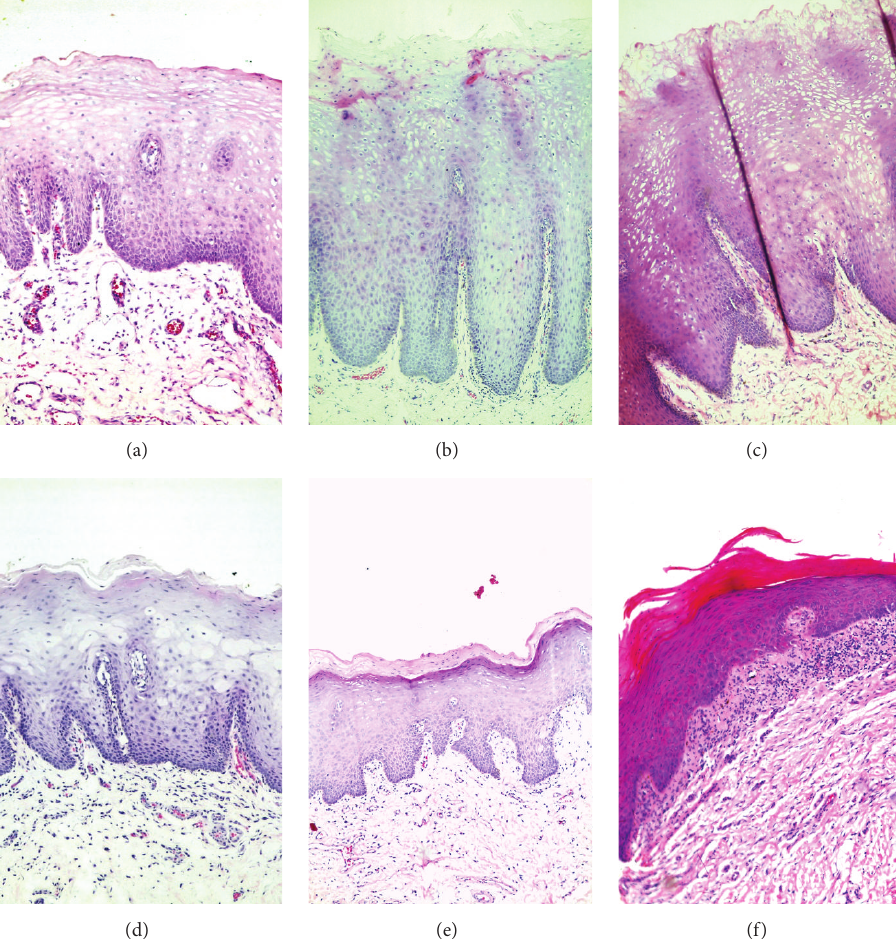
Figure 3: Histological preparations of biopsies from a nonchewer (a) and khat chewers. Acanthosis and intracellular edema are seen both in a smoker (b) and a nonsmoker (c). Varying degrees of keratinization are seen in samples from a mild khat chewer (d), a heavy khat chewer (e), and a heavy khat chewer who also smoked tobacco (magnification × 200). There were no histological differences between smokers and